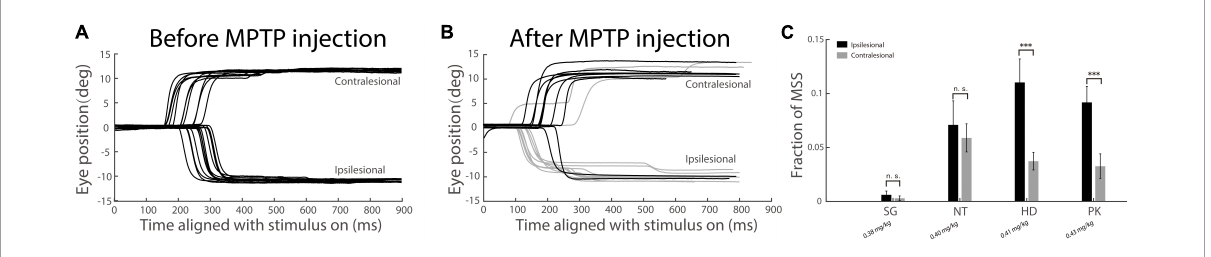
FIGURE7 Comparison of the incidence of MSS between ipsilesional and contralesional saccades in subclinical hemi-PD monkeys. (A,B) Exemplified horizontal eye traces of monkey PK before and after MPTP injection. The X -axis represents the time aligned with the saccadic target onset. The Y -axis represents the eye position. Black traces denote one step saccades, or one primary saccade followed by a corrective saccade. Gray traces denote MSSs. The incidence of MSS is greater in ipsilesional saccades than that in contralesional saccades. (C) The incidence of MSS in population level between the ipsilesional and contralesional saccades. There is a significant difference between the ipsilesional and contralesional saccades in monkey HD and PK who received bigger dose of MPTP injection. Error bars show the standard error of the mean; ∗∗∗ p < 0.001, n.s., no significant difference (Wilcoxon rank-sum and sign-rank